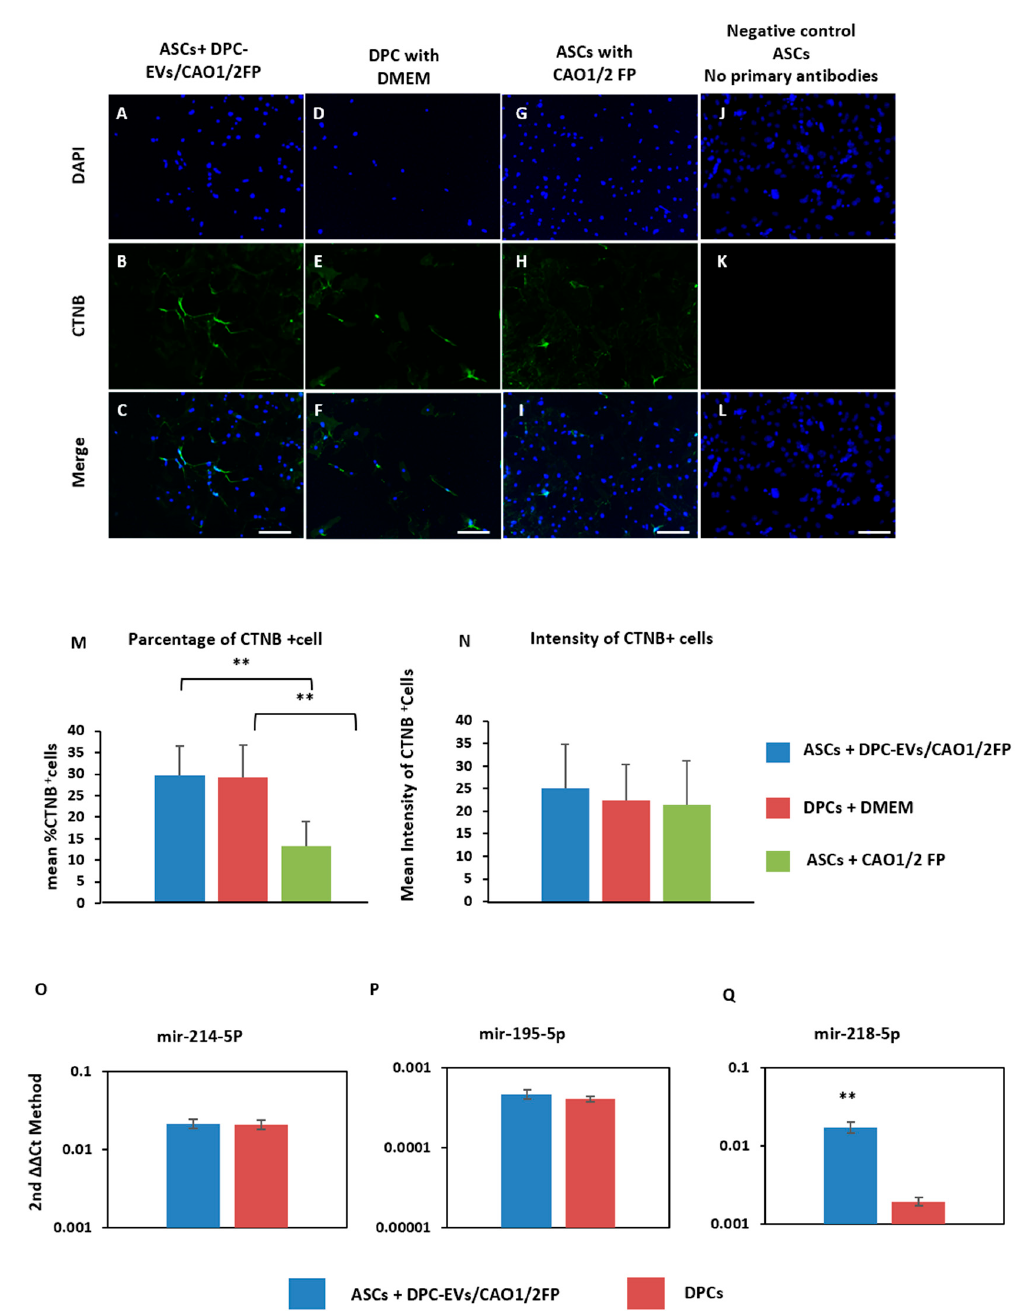
Figure 5. Immunofluorescence microscopic analysis of CTNB in adipose-derived stem cells (ASCs) under various conditions. ( A – C ) Immunofluorescence image of CTNB-positive cells in ASCs treated with DPC-EVs/CAO1/2FP, ( D – F ) dermal papilla cells (DPCs) with DMEM, and ( G – I ) ASCs with CAO1/2FP. ( J – L ) Negative control with no primary antibodies. ( M ) Percentage of CTNB-positive cells of total nuclei from randomly selected images. ( N ) Fluorescence intensity of CTNB-positive cells was quantified with Image J software 1.8.0_172. ( O – Q ) CTNB regulatory miRNA expression between DPCs and DPC-derived extracellular vesicles (DPC-EVs) treated ASCs with CAO1/2FP, white scale bar represents 100 µ m. Vertical bars represent the mean value ± SD (Error bars), ** p <